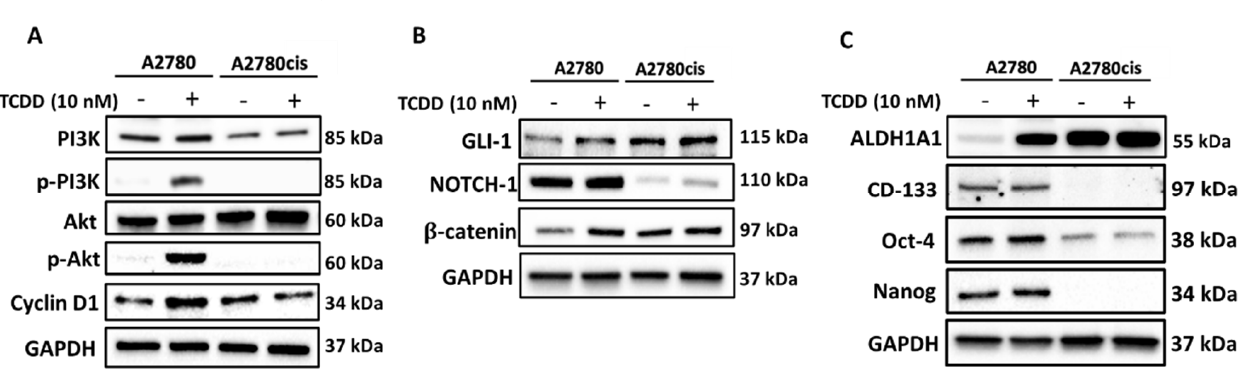
Figure 4. Effect of AhR activation on transcription factors and stemness markers in A2780 and A2780cis cells. A2780 and A2780cis cells were treated for 24 h with 10 nM TCDD. Protein expression levels of ( A ) PI3K, p − PI3K, Akt, p ‐ Akt, and Cyclin D1, ( B ) GLI − 1, NOTCH1, and β− catenin, ( C ) ALDH1A1, CD − 133, Oct − 4, and Nanog were determined by Western blot analysis. The protein panels are a composite of different blots and are representative blots for the indicated proteins and the loading control. The semi − quantitative analysis of the expression of the target proteins is presented in Figure S1.